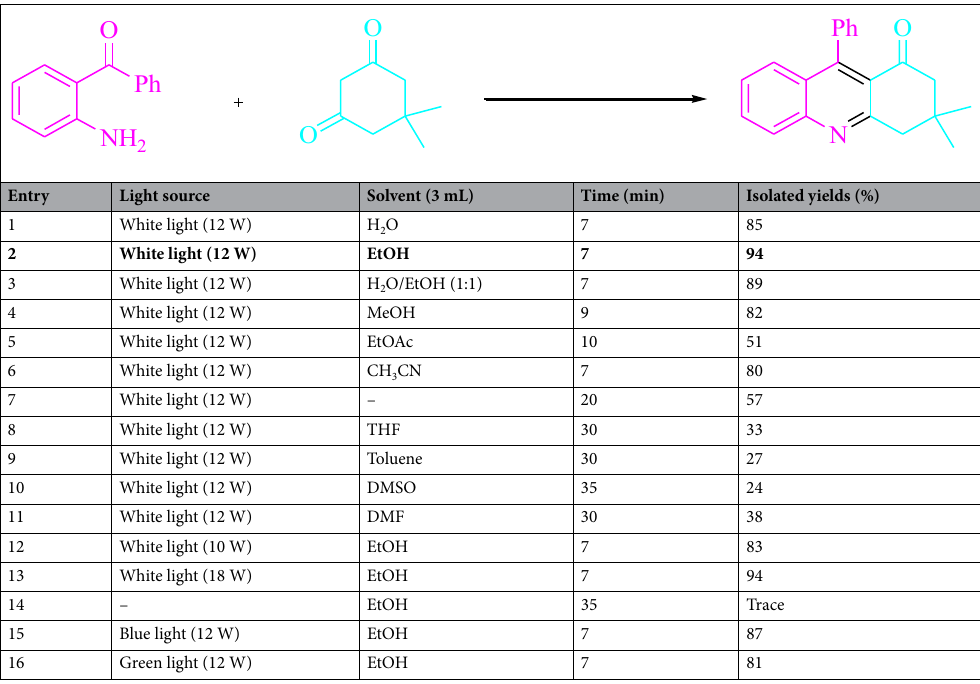
Table 2. Table of solvent and visible light optimization for 3a synthesis. Reaction conditions: 2-aminobenzophenone (1.0 mmol) and dimedone (1.5 mmol) were added to MB + at room temperature (1 mol%). Significant values are in